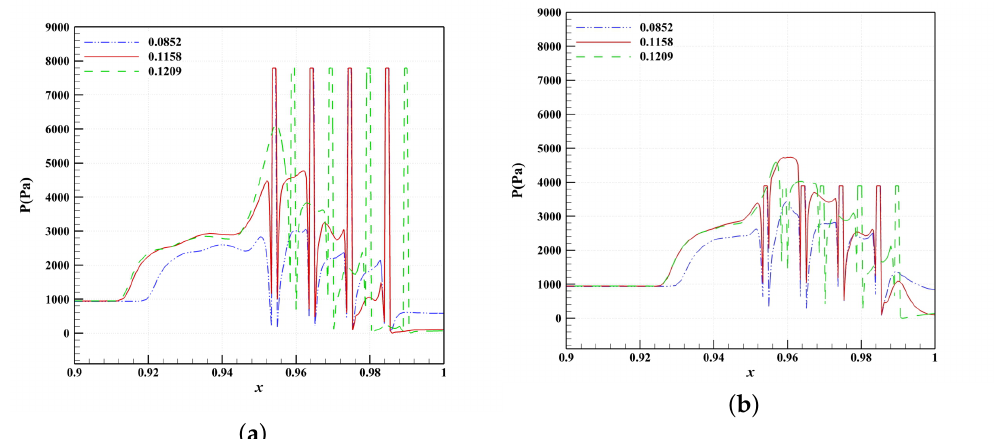
Figure 13. Surface Pressure Distribution on Selected Section Planes (Cases 4 and 5 at Section Plane z = 0.0852 (Blue, Dashed Dotted), 0.1158 (Red, Solid) and 0.1209 (Green, Dashed)). ( a ) Case 4 ( C M = − 0.006832), ( b ) Case 5 ( C M =